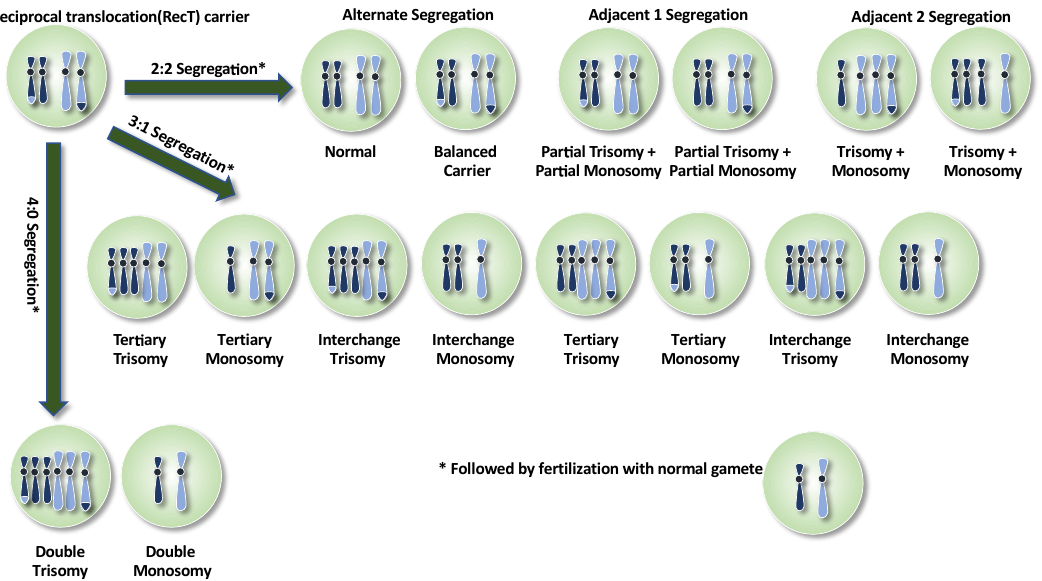
Figure 2. Segregation patterns of a reciprocal translocation (RecT) i in the resulting embryos followed by fertilization with a normal gamete.